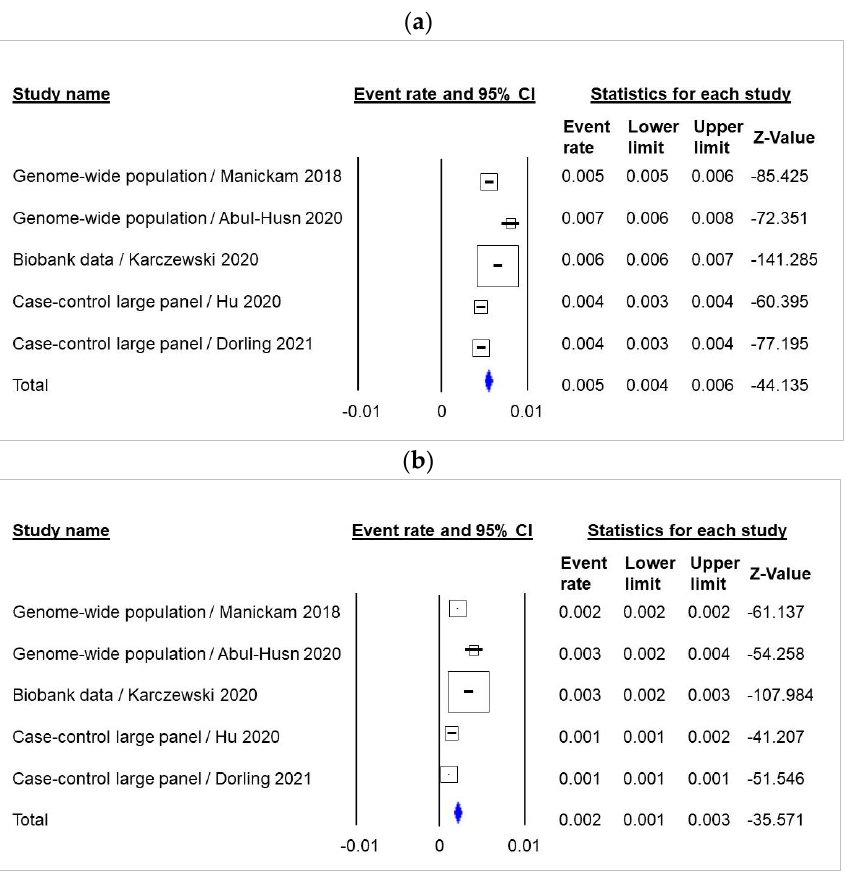
Figure 3. Meta-analysis of gBRCA1 and gBRCA2 carriers among 238,972 unaffected individuals. ( a ) gBRCA carriers among unaffected individuals; ( b ) gBRCA1 carriers among unaffected individuals; ( c ) gBRCA2 carriers among unaffected individuals. The frequency of gBRCA1 and gBRCA2 was 0.18% (95% CI 0.12–0.25) and 0.32% (95% CI 0.27–0.38), respectively (Figure 3b,c, Supplementary Materials, S3, S4). There was no evidence of publication bias in the funnel plot (Supplementary Materials, Meta-Analysis S9 and S10, respectively) or by Egger’s test. The frequency of heterozygous gBRCA1 and gBRCA2 was estimated at 1/434 and 1/288, respectively (Supplementary Materials, Table S3). The BRCA2 gene accounted for 60% of all gBRCA carriers in the general population (Figure 2c, Supplementary Materials, Table S3).